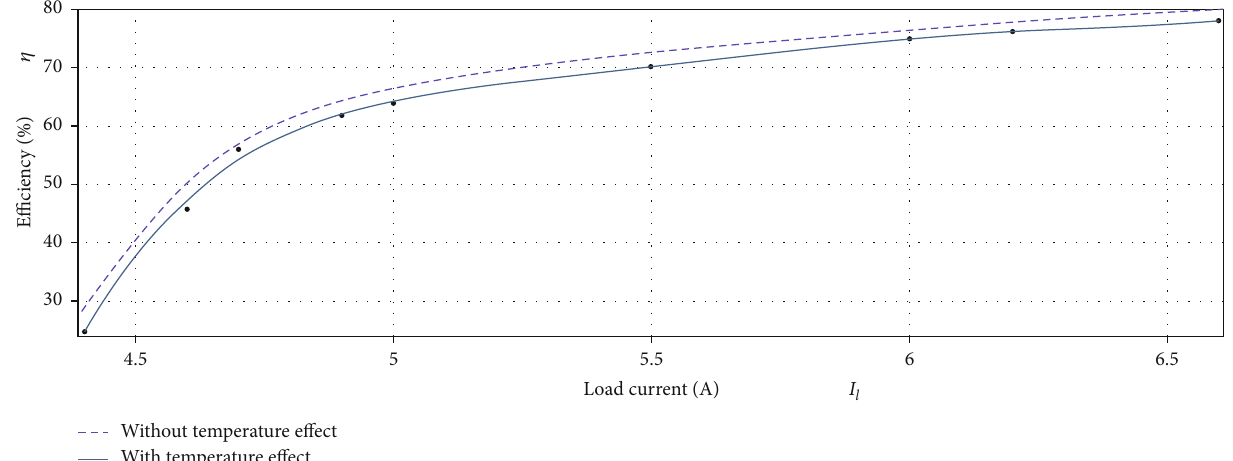
Figure 8: Variation of load current with machine e ffi ciency with and without temperature, skin, and saturation e ff